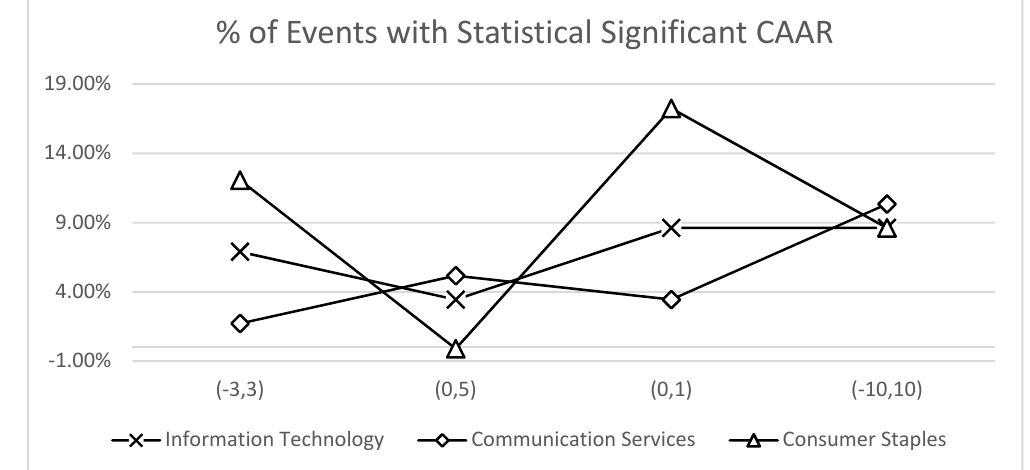
Figure A3. Overview of the impact of geopolitical risk (Historical Sector Average CAAR) on the Information Technology, Communication Services, and Consumer Staples sectors.